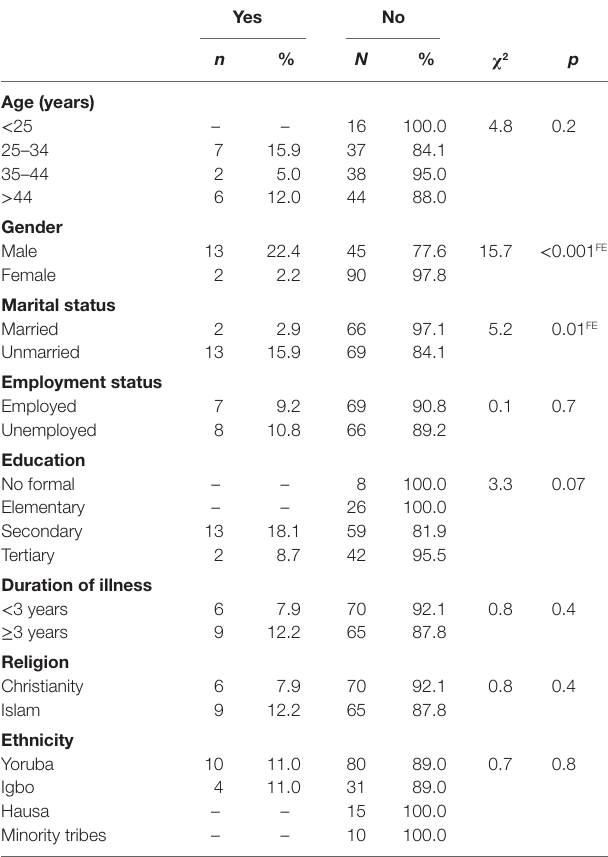
TaBle 2 | sociodemographic characteristics of cannabis use among patients with schizophrenia ( N =